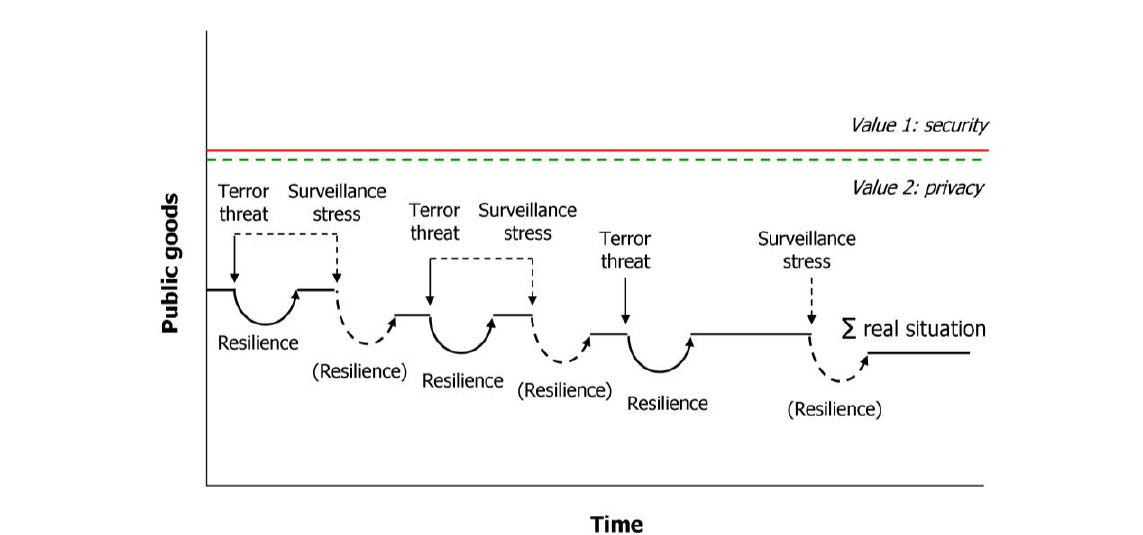
Figure 12. Terror threats and surveillance stresses in a separate public goods model (observed